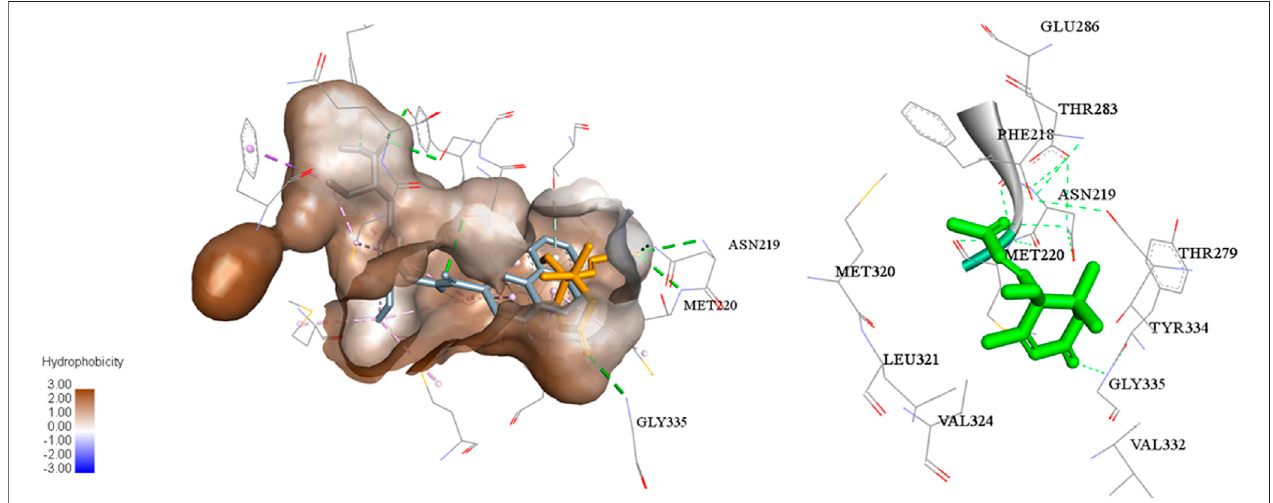
FIGURE 5 | Molecular docking model of compound 1 binding to PPAR α .